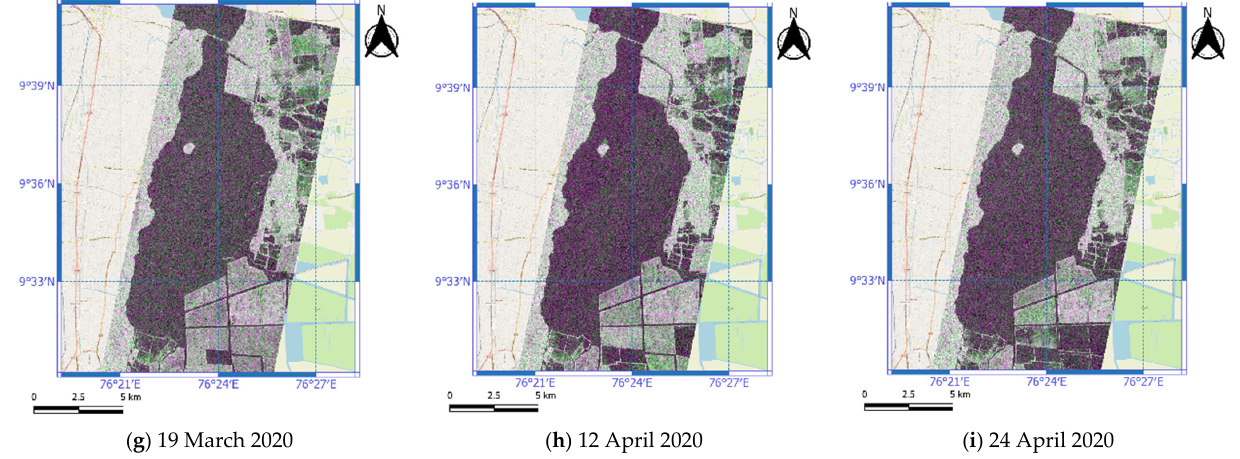
Figure 4. RGB composites (VV, VH, VV/VH) of SAR images acquired over Vembanad Lake, high- lighting the temporal changes of water hyacinth within the lake (Sentinel-1, Credits: ESA).